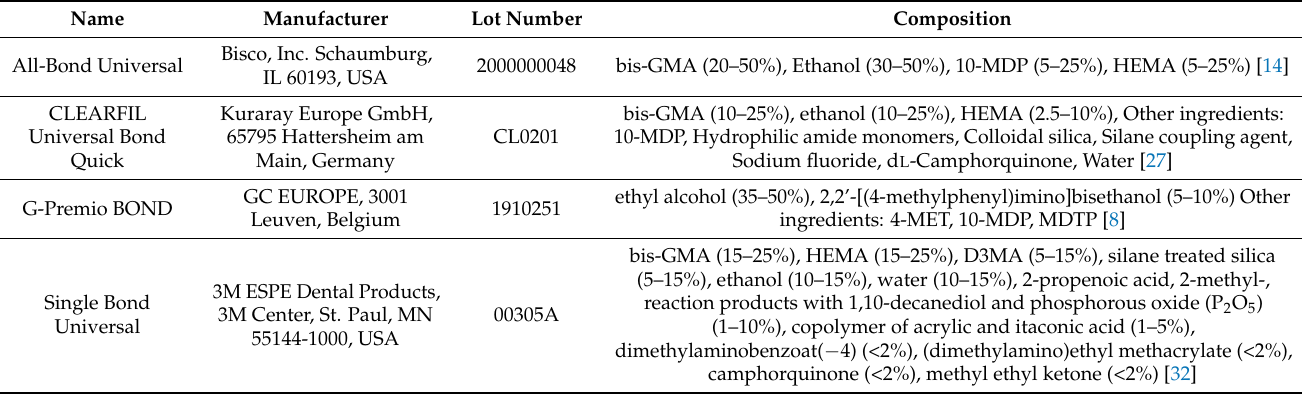
Table 1. Universal dental adhesives used in the